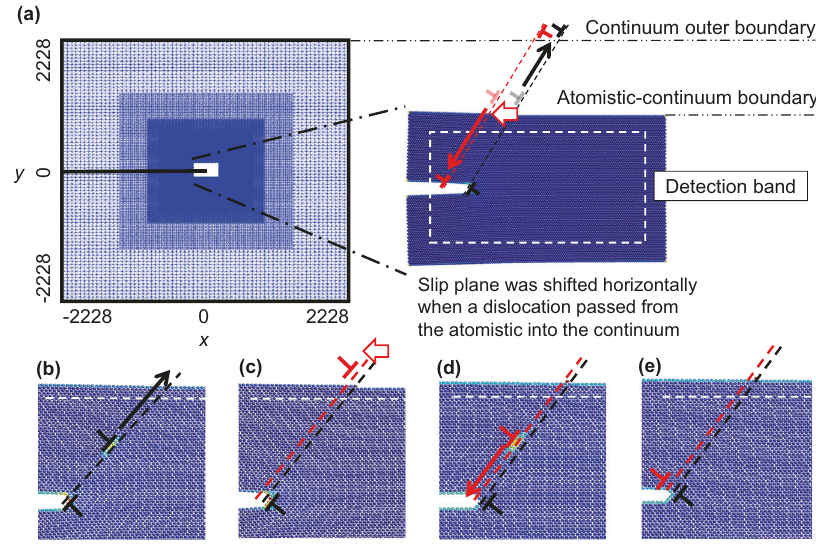
Fig. 7 Illustration of slip plane shifting implementation. An overview of the implementation is given in ( a ) that corresponds to the detailed sequence shown in ( b ) through ( e ). When a dislocation (black) nucleated from the crack tip and glided across the detection band inside the atomistic domain ( b ), its slip plane was shifted after being passed across the interface (red), ( c ). In order to maintain the correct displacement fi elds of both the original and the shifted dislocations, the previously passed dislocation (black) was moved and pinned outside the continuum domain and a new “ opposite ” dipole dislocation (red) on the shifted slip plane was added. During unload, the shifted (red) dislocation glided back into the atomistic domain, ( d ), and eventually returned to the crack tip ( e ). In all slip plane shifting simulations, the distance of each shift is 1 b . The lengths given in this fi gure are normalized with respect to the magnitude of the Burgers vector, b , and the images are not drawn to